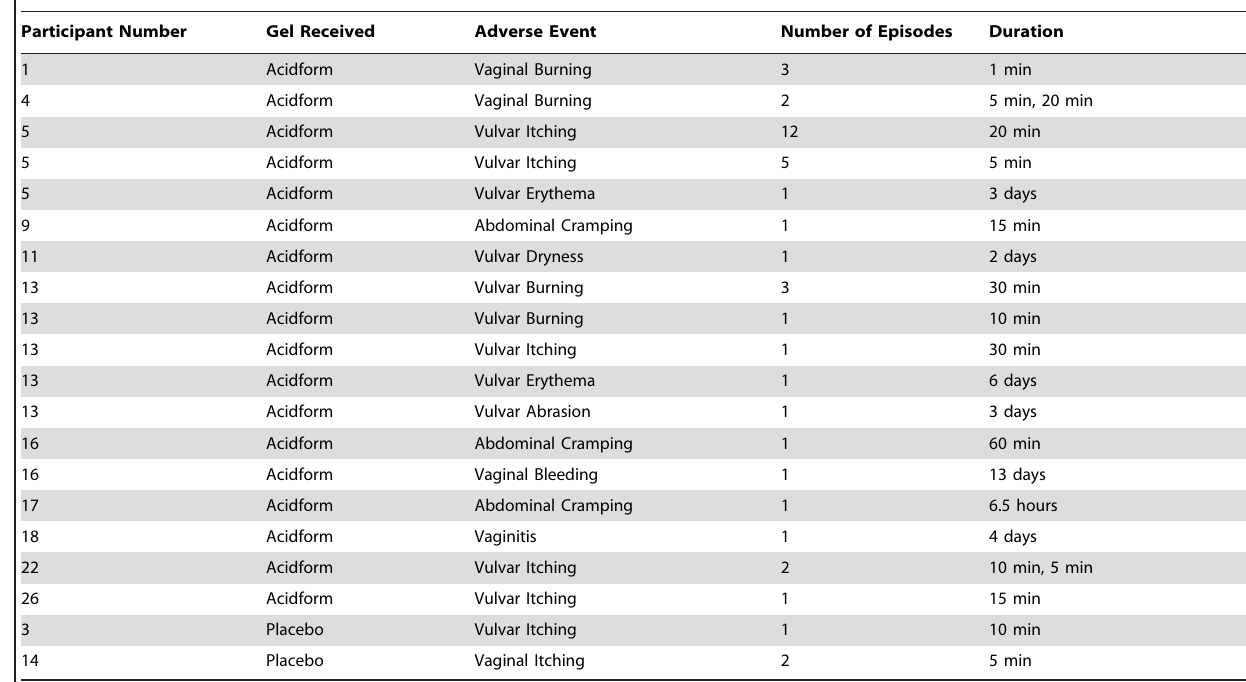
Table 2. Adverse events related to Acidform and HEC placebo